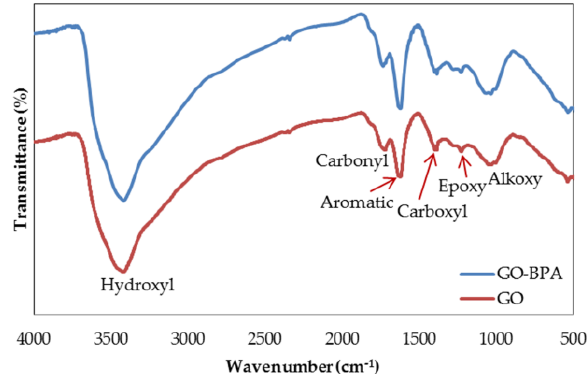
Figure 9. The oxygen-containing functional groups (OCFGs) on the GO surface analyzed by Fourier transform infrared spectroscopy (FTIR).